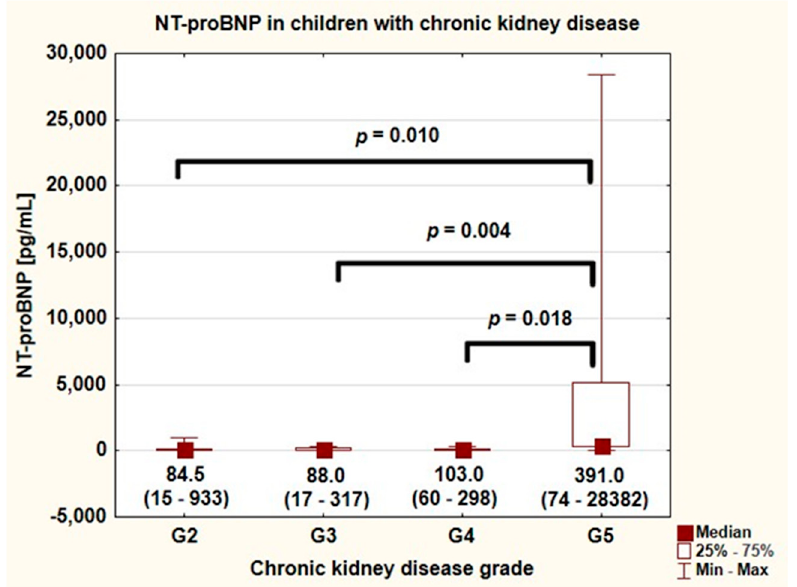
Figure 2. NT-proBNP in children with chronic kidney disease (median value and range) (G—chronic kidney disease grade).